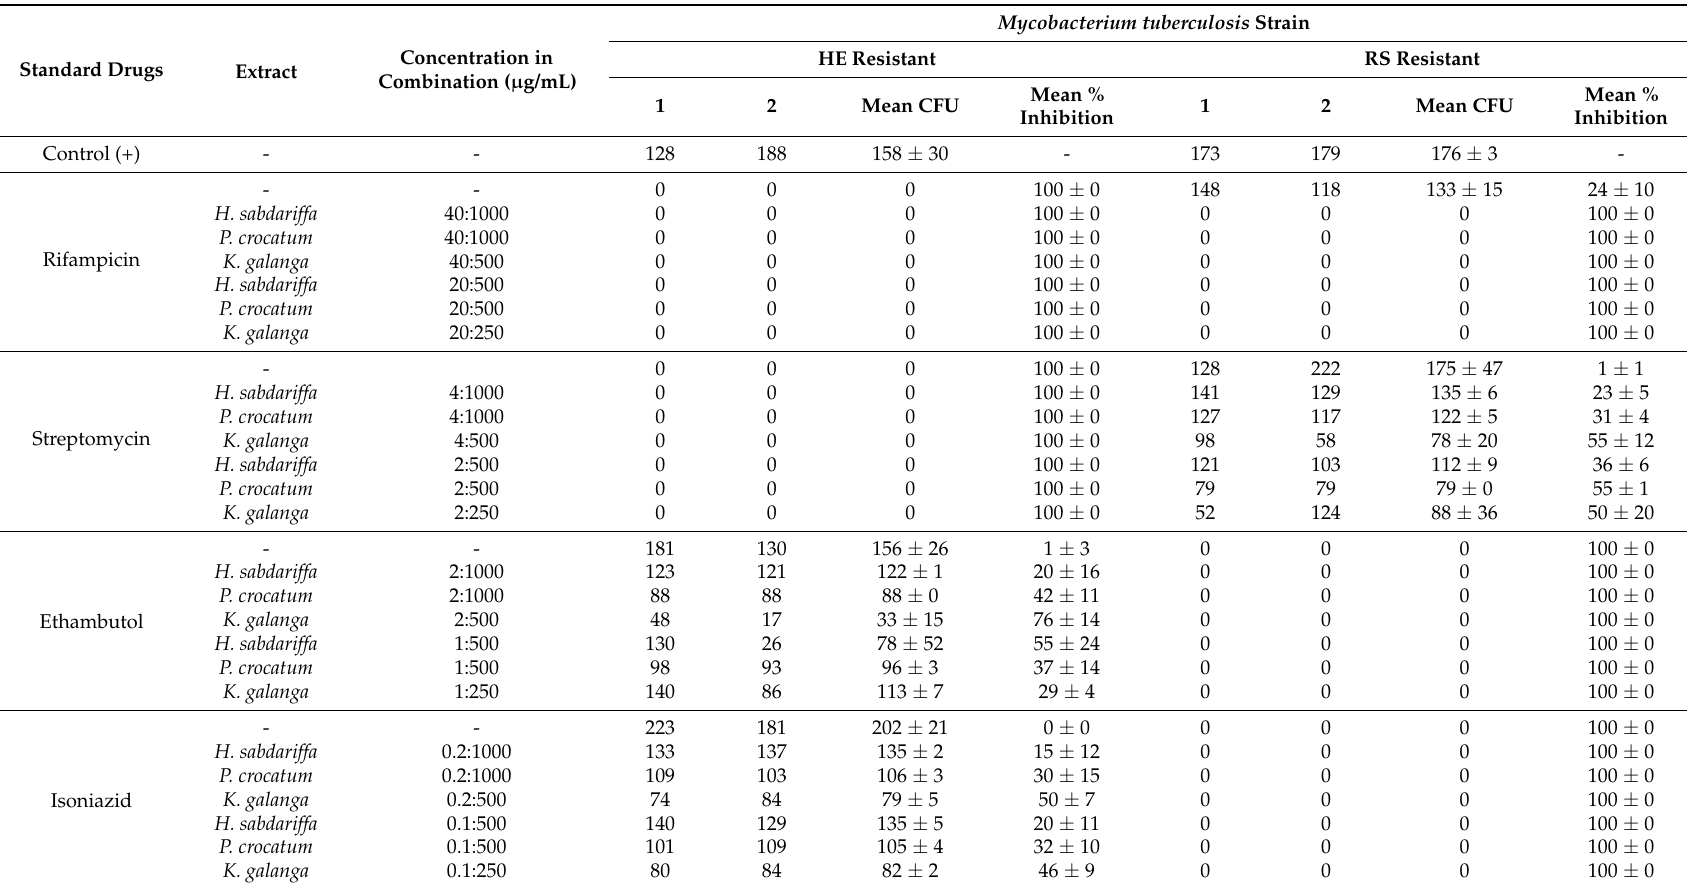
Table 4. The percentage of inhibition for various combinations of antituberculosis drug and extract against MDR Mycobacterium tuberculosis